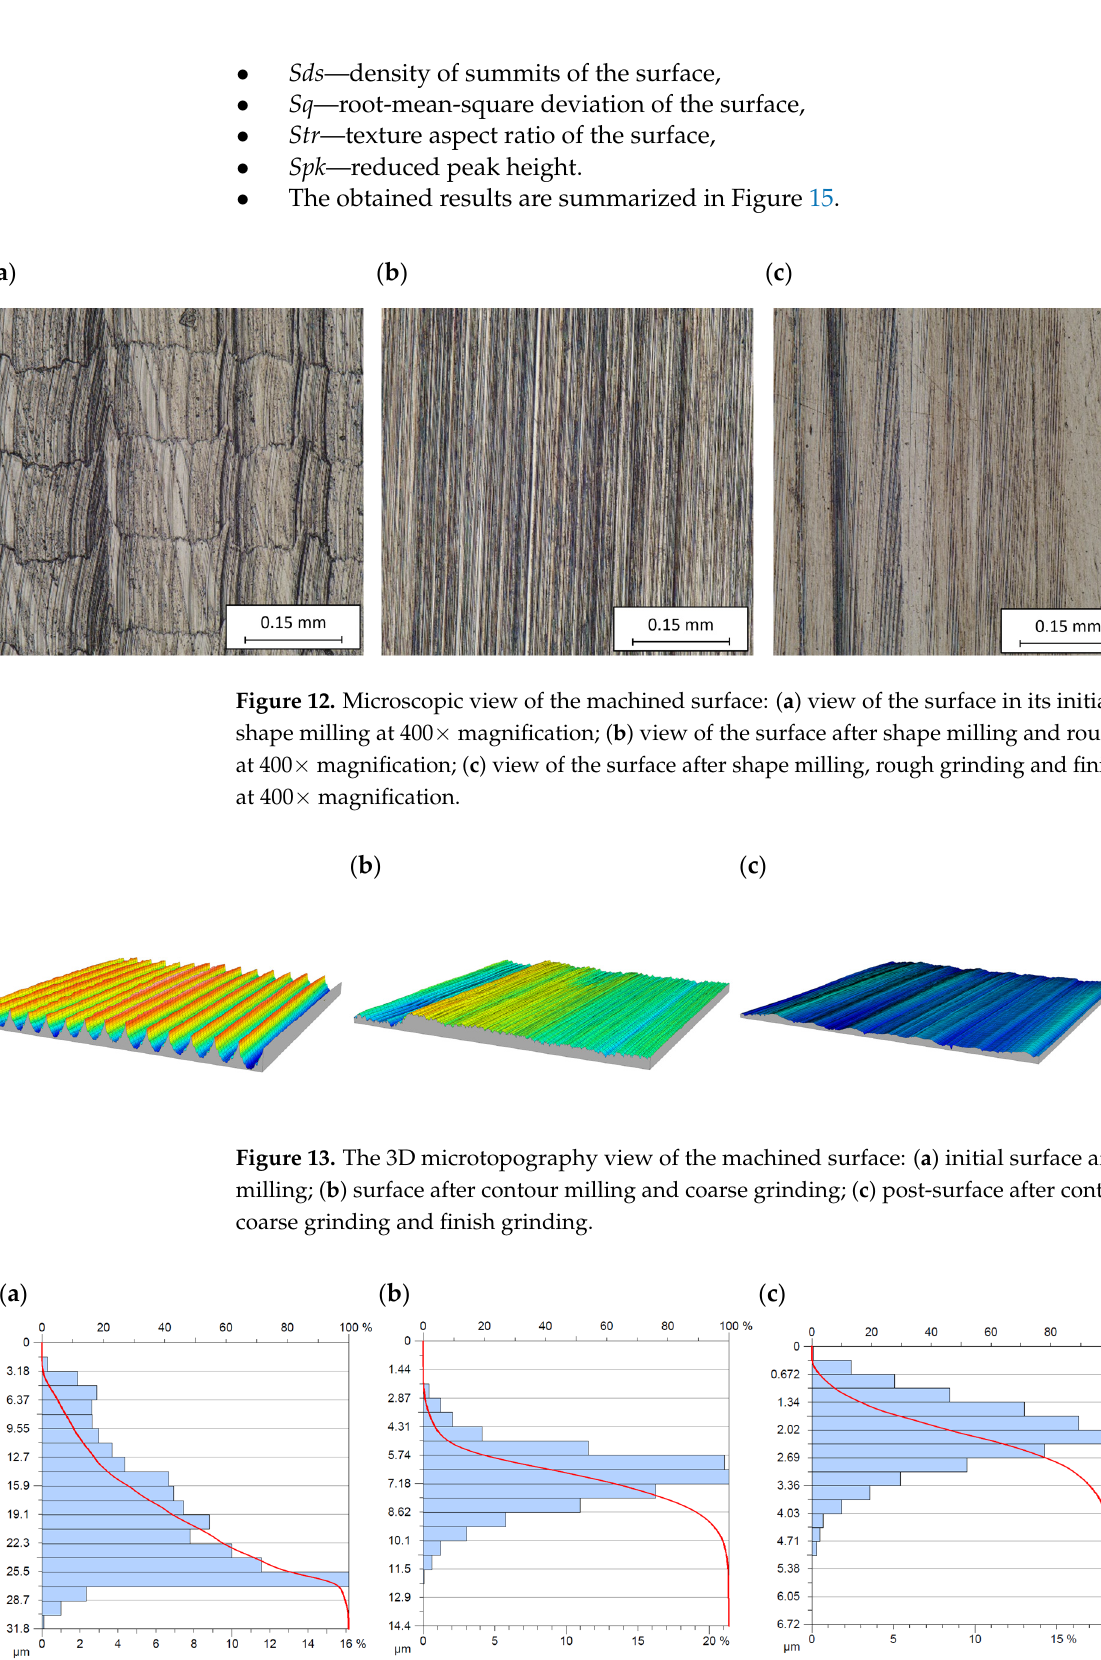
( f ) Figure 15. Summary graphs of selected surface roughness parameters after contour milling (Step 1), after contour milling and coarse grinding (Step 2), and after contour milling, coarse grinding and fi nish grinding (Step 3): ( a ) Sa —Arithmetic mean deviation of the surface; ( b ) St —Total height of the surface: ( c ) Sds —Density of summits of the surface; ( d ) Sq— Root-Mean-Square Deviation of the Surface; ( e ) Str— Texture Aspect Ratio of the surface; ( f ) Spk— Reduced Peak Height. Analysis of the Abbo tt -Fireston load-bearing curve showed that with each successive machining of the workpieces, the magnitudes of the parameters describing the height of the surface roughness decreased. The values of parameters such as Sa , St , Sq and Spk de- creased, as evidenced by a decrease in the arithmetic mean deviation of the surface from the mean surface of 5.30, 1.12, 0.63 µm, sequentially, reductions in the vertical distance between the peak of the highest apex and the lowest depression of the surface of 31. 8, 14.4 and 6.72 µm, reductions in the mean square deviation of the height of the surface irregu- larity from the reference plane of 6.39, 1.46, 0.81 µm, successively, and reductions in the height of the vertices of 6.16, 0.77, 0.33 µm, successively. This means that the evaluated surfaces in each successive machining step had increasingly lower roughness values, and thus were increasingly smoothed. The value of the Sds parameter, which provides infor- mation on the number of vertices per unit area, increased in successive processing stages (393, 563, 1203 pks/mm 2 ), which means that, although the number of vertices increased,